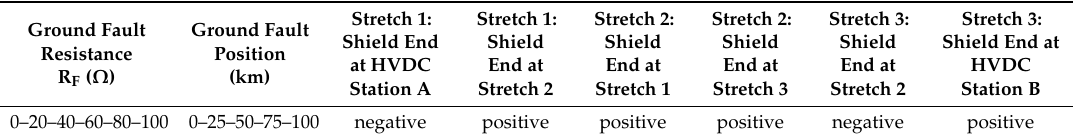
Table 6. Polarities of currents in shields with ground fault in Cable A, Stretch 2. Polarity of currents at the ends of the shields.